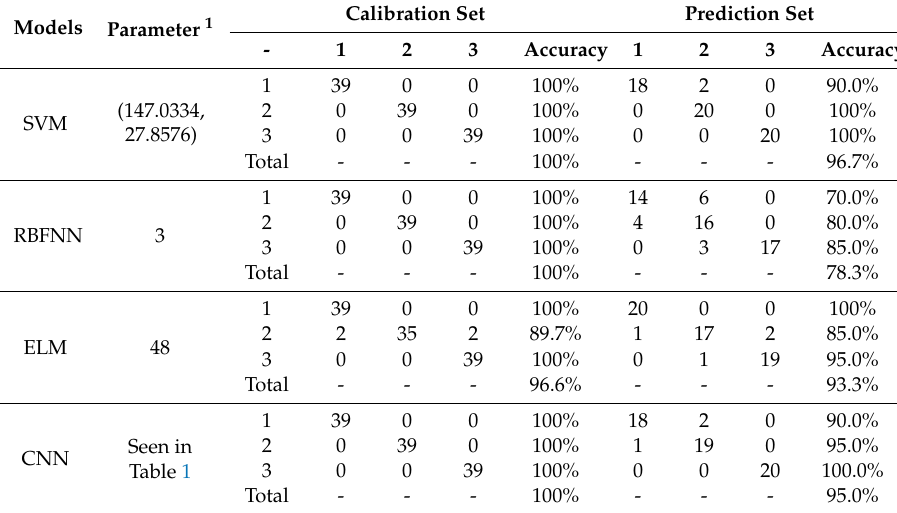
Table 4. The discriminant results of support vector machine (SVM), radial basis function neural network (RBFNN), extreme learning machine (ELM), and convolutional neural network (CNN) models on the selected spectral